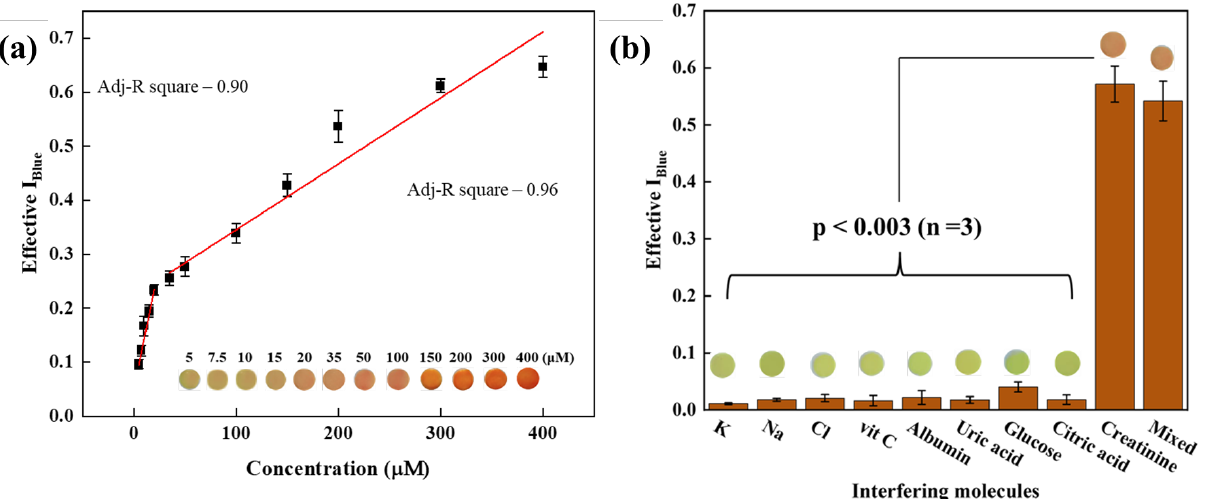
Figure 5. ( a ) Standard calibration graph showing two different dynamic ranges of creatinine from 5 to 20 μM and from 35 to 400 μM ; ( b ) Selectivity assay of C/DZ/EDC-NHS/anti-CR sensor probe towards interfering molecules present in the serum and mixed-sample analysis.